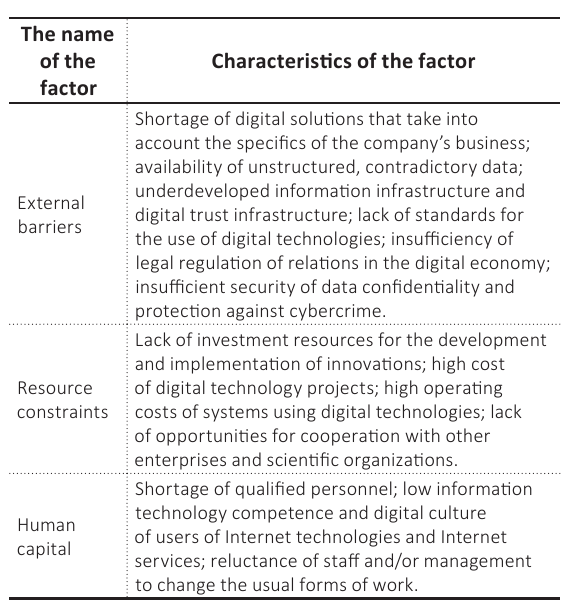
Table 3. Characteristics of factors that hinder the development of digitalization of society in Ukraine